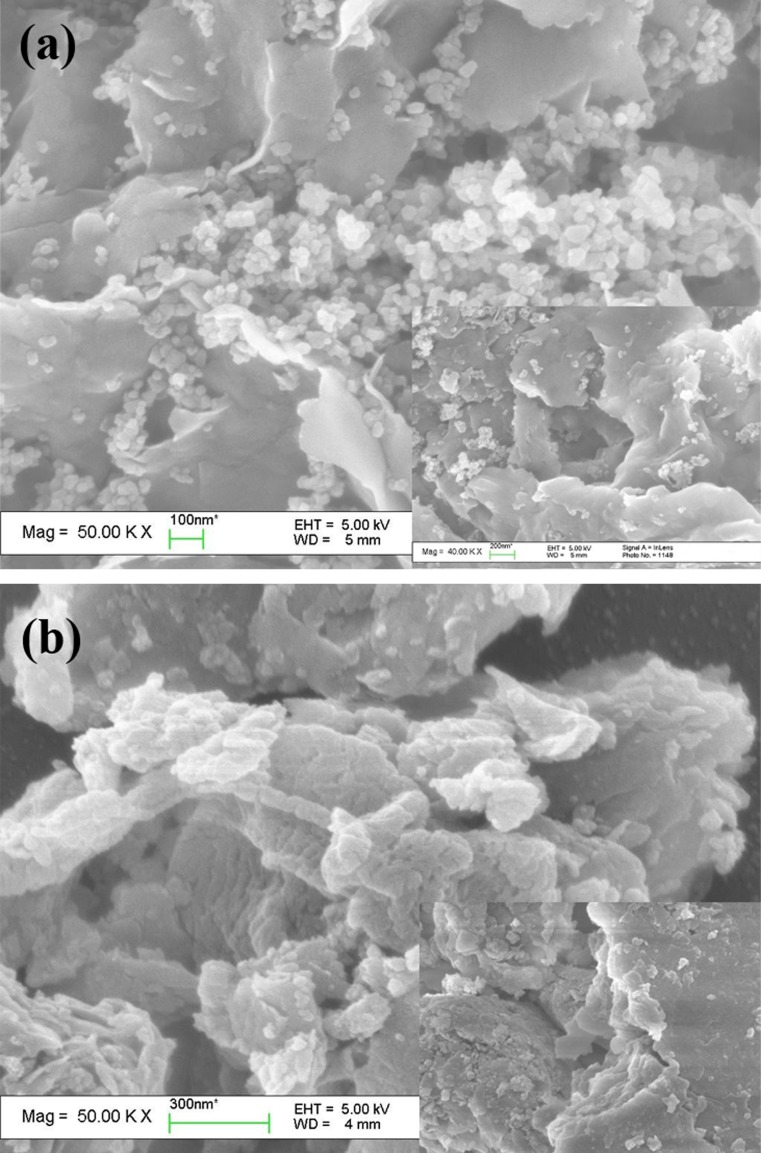
SEM images of Ca-Mt and APTES3.0CEC-Mt.